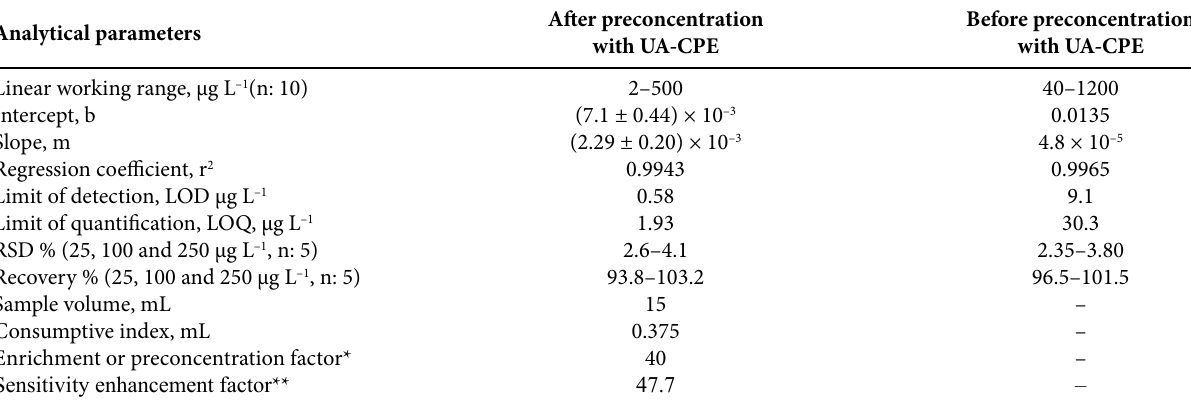
Table 1. The analytical features of the proposed preconcentration method